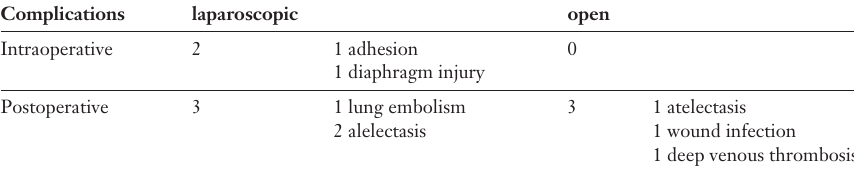
Table 3 Intra- and postopera- tive